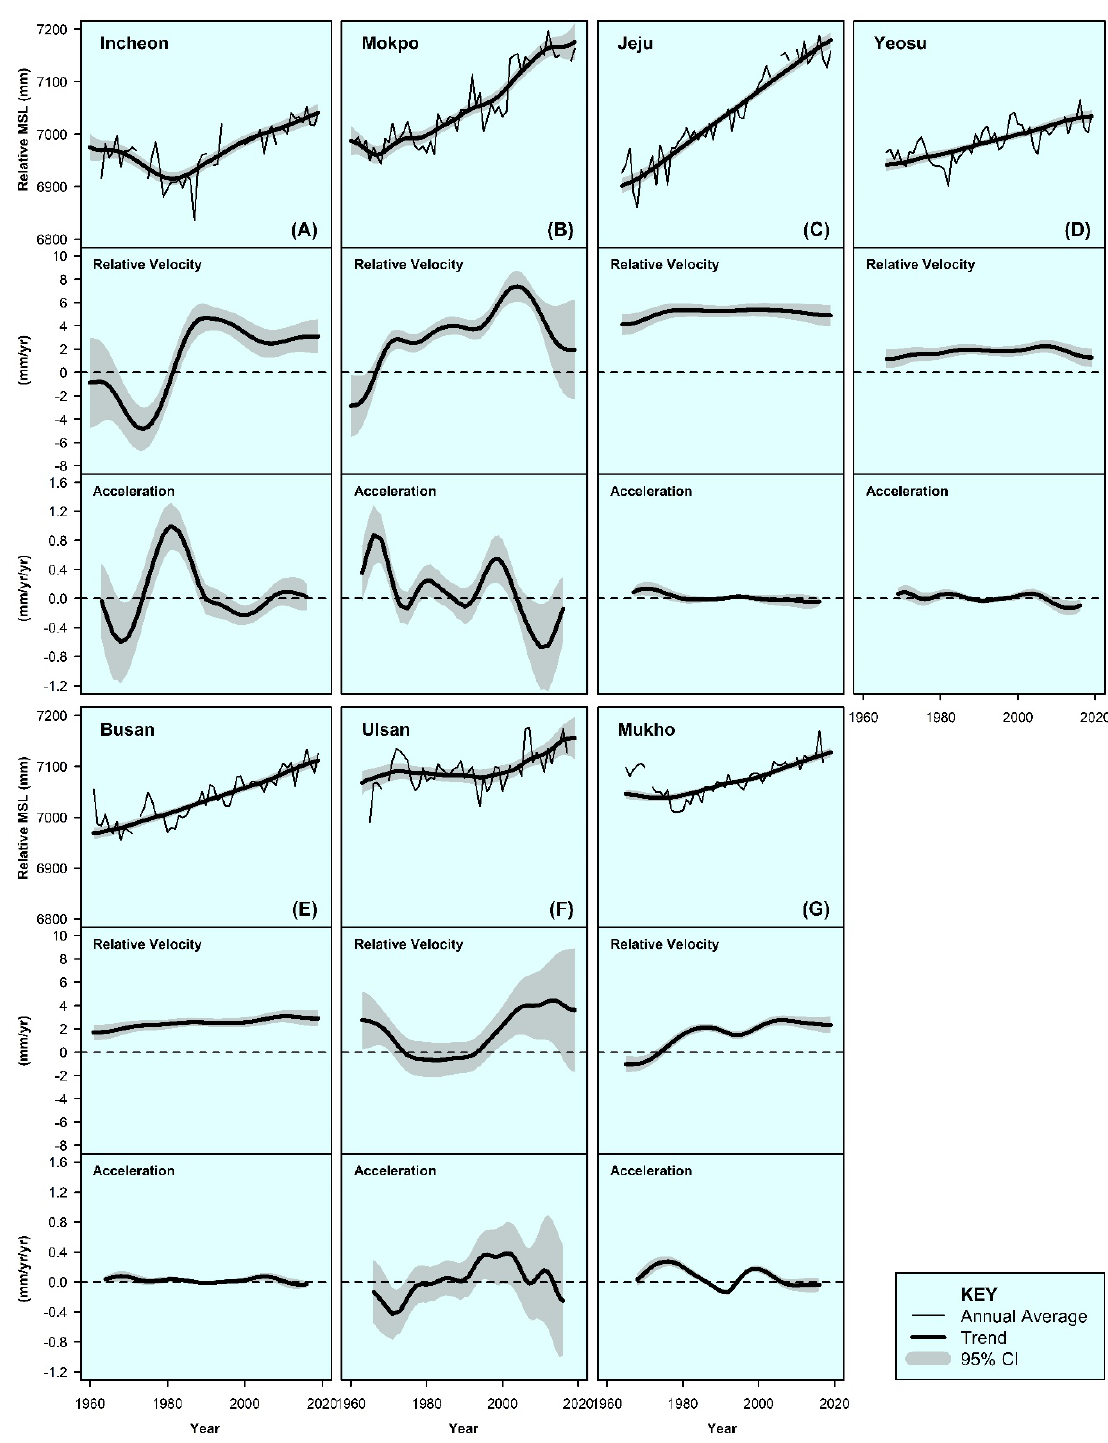
Figure 2. “Relative” mean sea level (trend) and associated velocity and acceleration from records longer than 50 years. The scales associated with each of the 3 panel charts for the respective tide gauge records are equivalent for direct comparison between records. Refer to Figure 1 and Table 1 for station details.